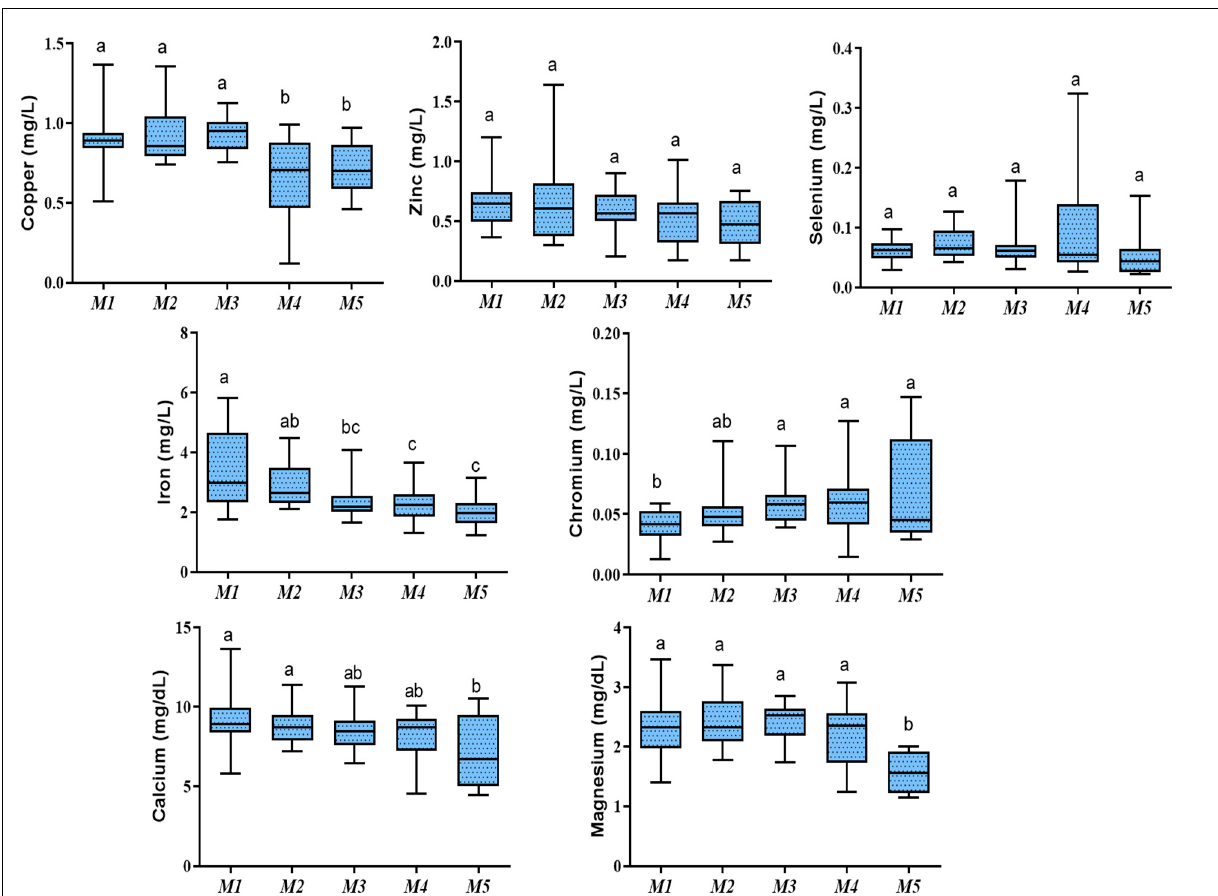
Figure 1. Whisker box plots showing the median (central horizontal line) and interquartile range (25% downward, 75% upward bars) of plasma element concentrations in male Shiba goat’s kids during the first five months of life. The upper and lower ends of the whiskers show the maximum and minimum values. Different letters indicate a significant difference between ages per month ( p < 0.05).